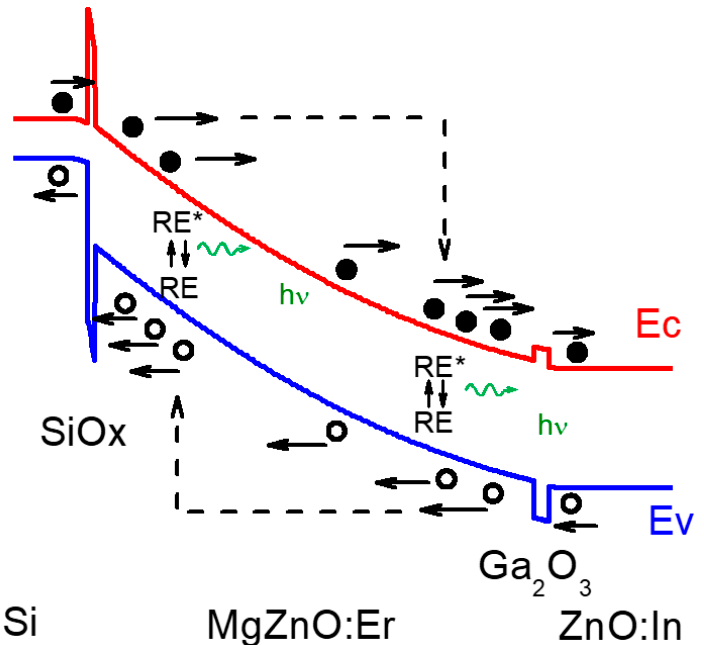
Figure 10. Schematic energy band diagram for the diode with barrier layers under reverse